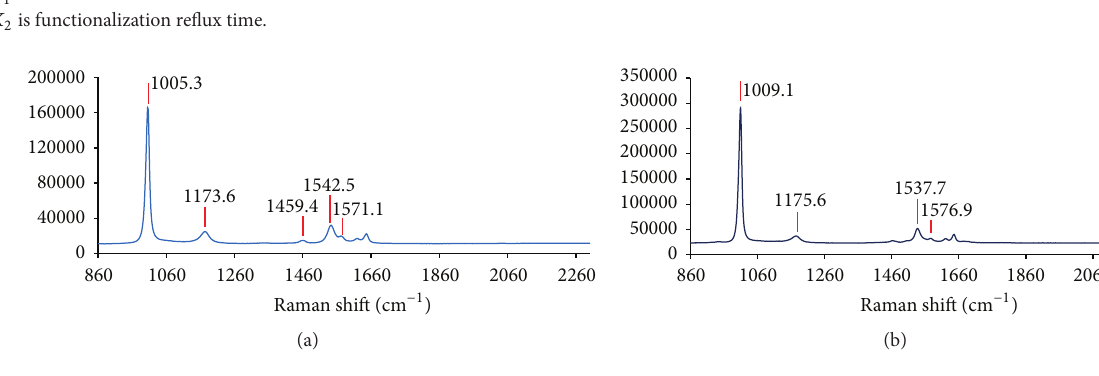
Figure 5: Raman spectra of (a) UF-MWCNTs in comparison to (b)